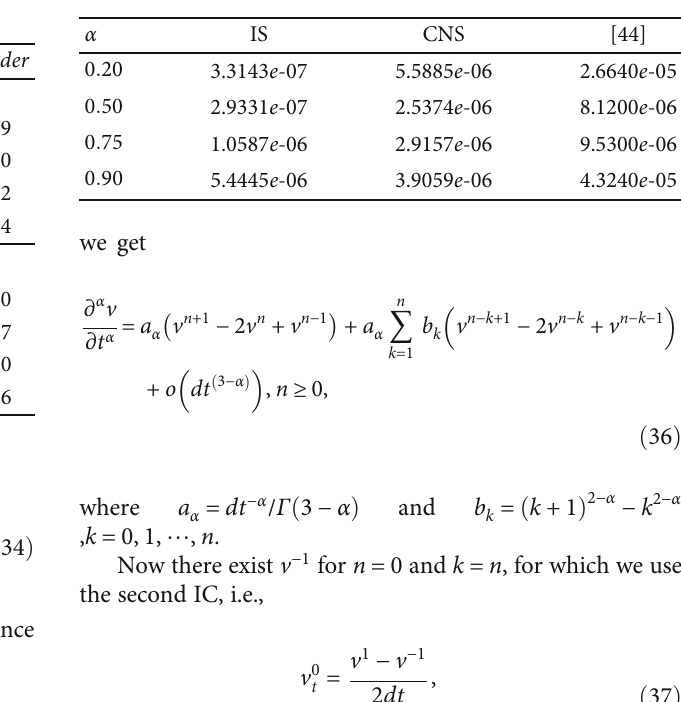
Table 5: Comparison with of E ∞ [44] for the Problem